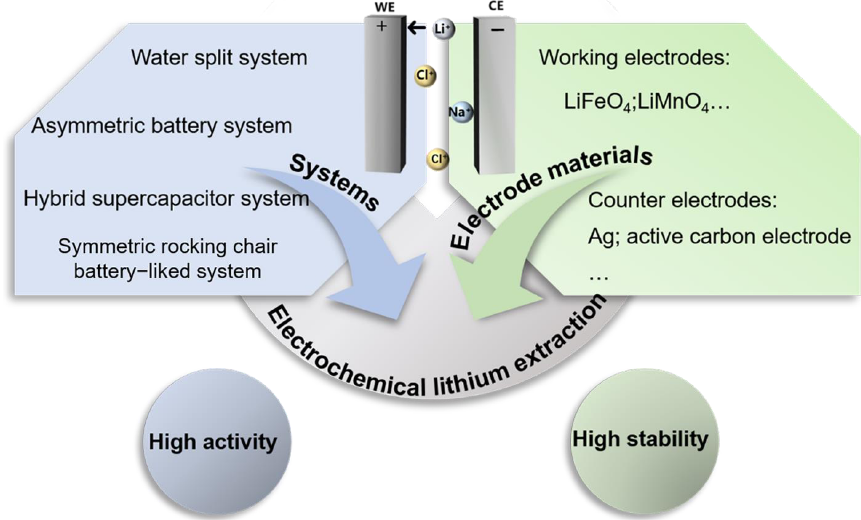
Figure 2. Schematic illustration of electrochemical lithium extraction.